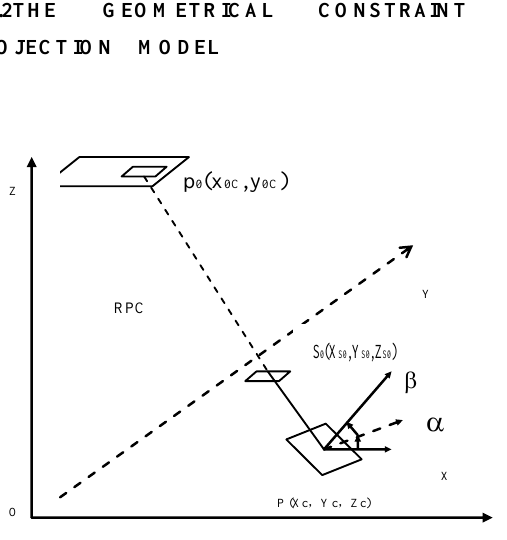
in the error equation the variates are the height of the centre of the slope C Z ,direction angle ,   , the variates in radiation h , h . 01 11